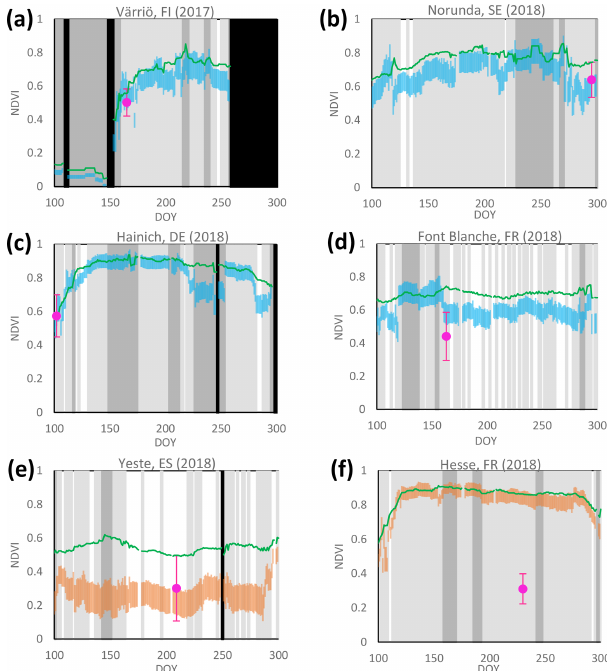
Figure 6. Seasonal courses of estimated understory NDVI (NDVIu) ranges (blue bars – site-representative retrievals; orange bars – pos- sible non-site-representative retrievals), nadir total (understory and overstory) NDVI values from MODIS BRDF/albedo data (green lines), and in situ measurements (mean ± 1 SD shown in purple) over selected study sites. Gray bars mark MODIS BRDF parameters with lower quality flags (light gray – QA = 1; dark gray – QA > 1). Black bars indicate where no data are